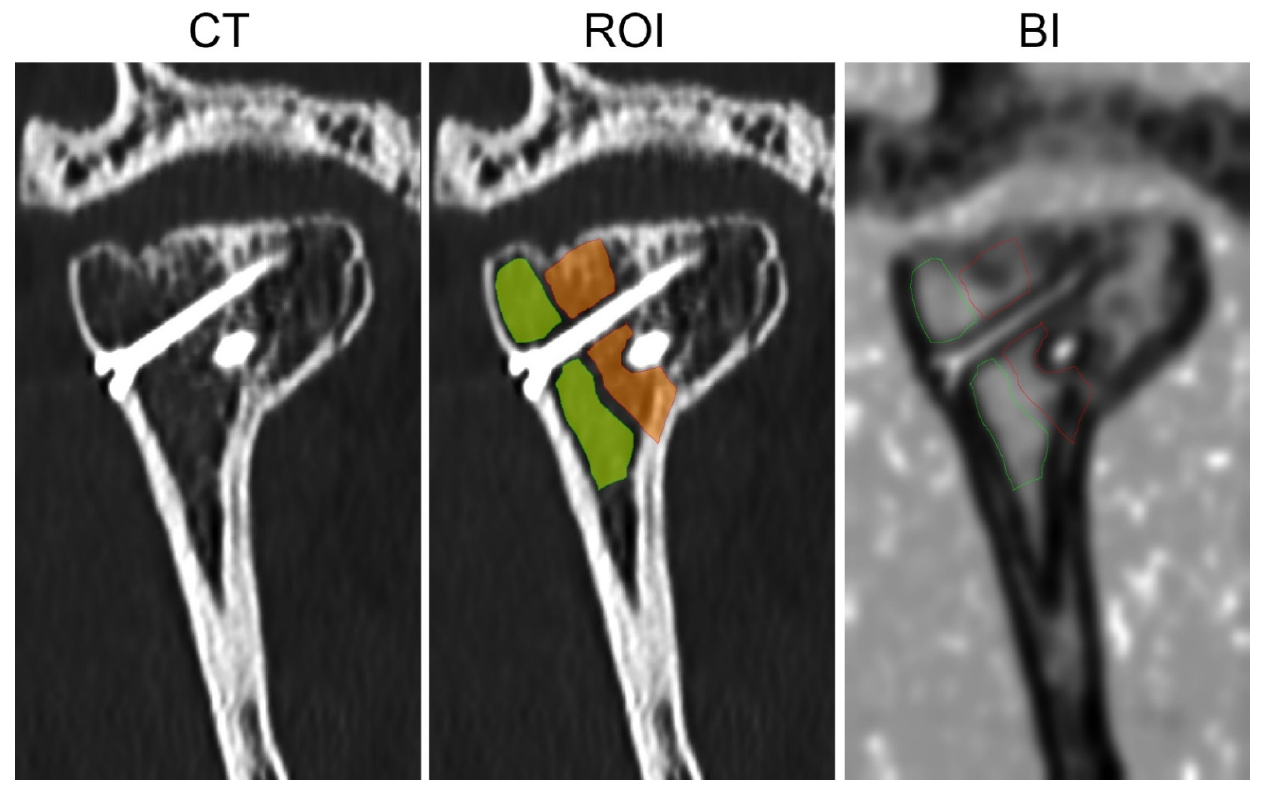
Figure 5. The method of bone union structure evaluation. CT—coronal section of mandible head in examination taken 12 months post-operationally. ROI—orange region covered post-fracture line area; green region describes control site of cancellous bone. BI—map of the Body Index, in which lighter regions indicate high value of the texture feature contrary to dark regions, where BI has low value. BI, as used in skeletal tissue image, is the marker of normal cancellous bone.